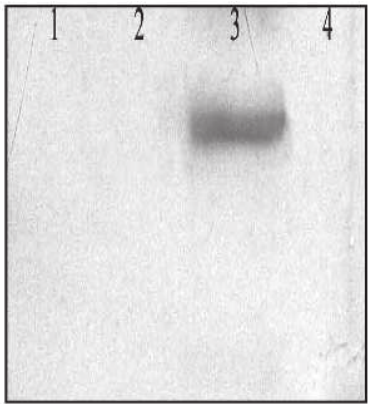
Fig. 2. – Analysis of the stage specificity of the subtracted probe T1- 2D7.